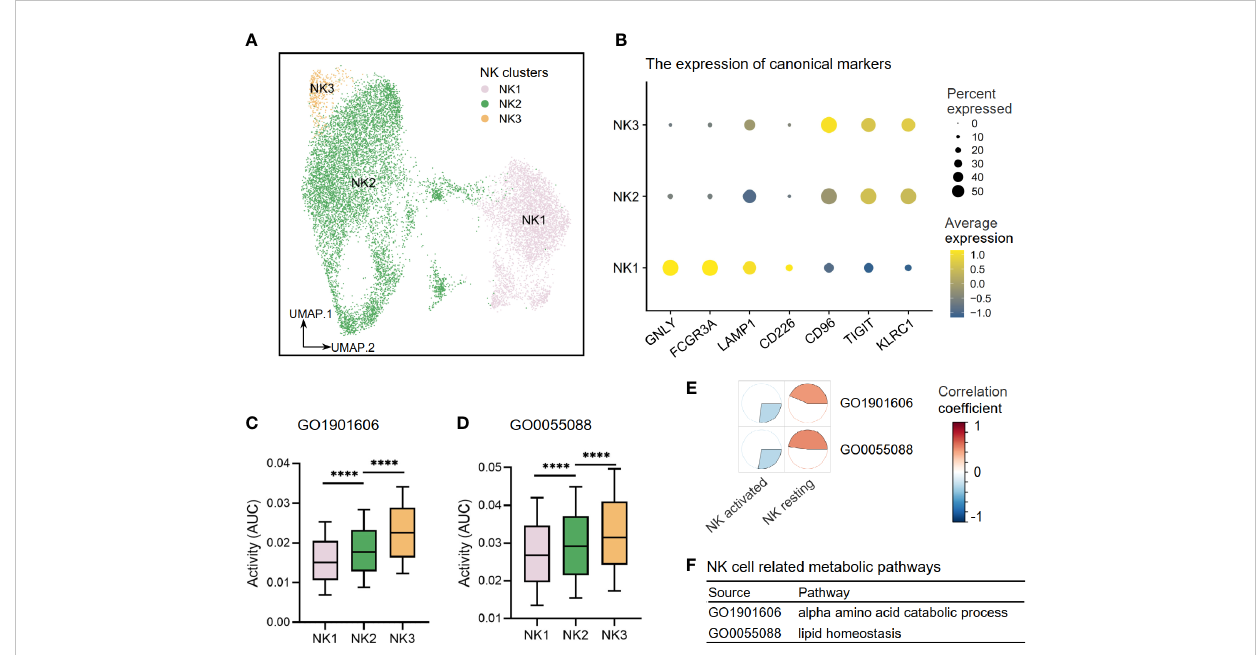
FIGURE 9 The metabolic perturbations of NK clusters in hepatitis. (A) UMAP visualization of the NK clusters. (B) Dot plot showing the expression levels of given genes in each cluster. (C, D) The activities of metabolic pathways in each NK cluster. (E) Heatmap showing Pearson ’ s correlation coef fi cients between the activities of metabolic pathways and the NK in fi ltration fractions. (F) NK-related metabolic pathways and corresponding database sources. UMAP, Uniform Manifold Approximation and Projection. ****means p <